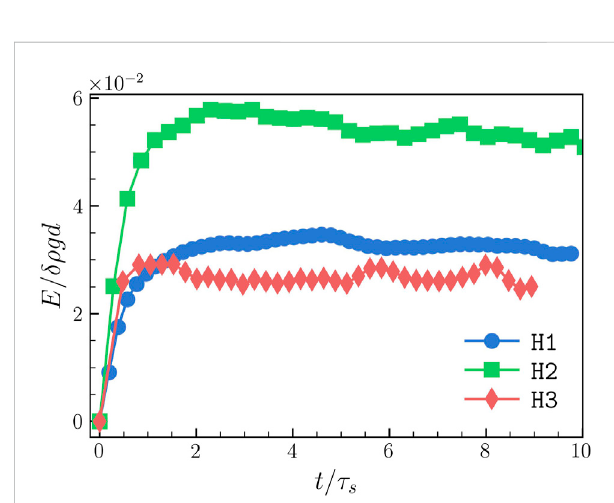
FIGURE 3 Time evolution of the kinetic energy E . A steady-state is attained for t ≥ 0.8 τ s , where τ s (cid:2) L /